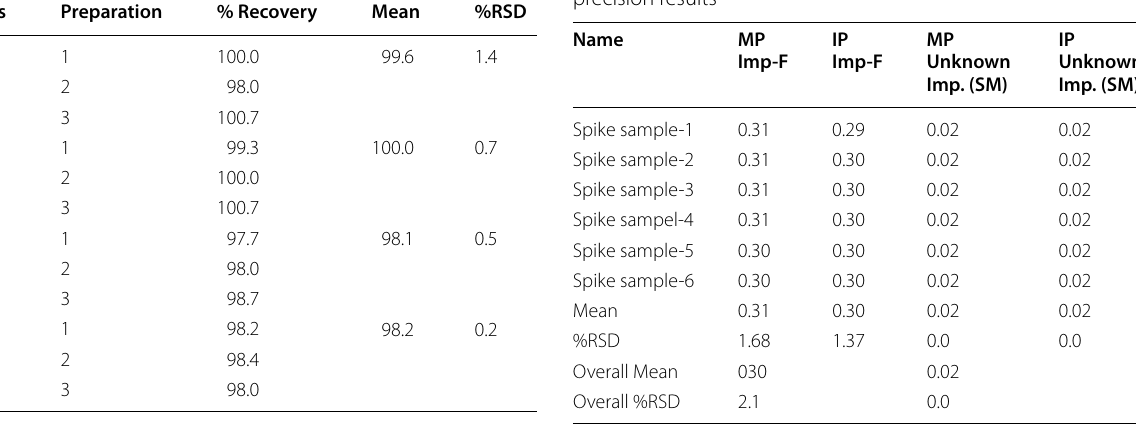
Table 9 Comparison of method precision and intermediate precision results